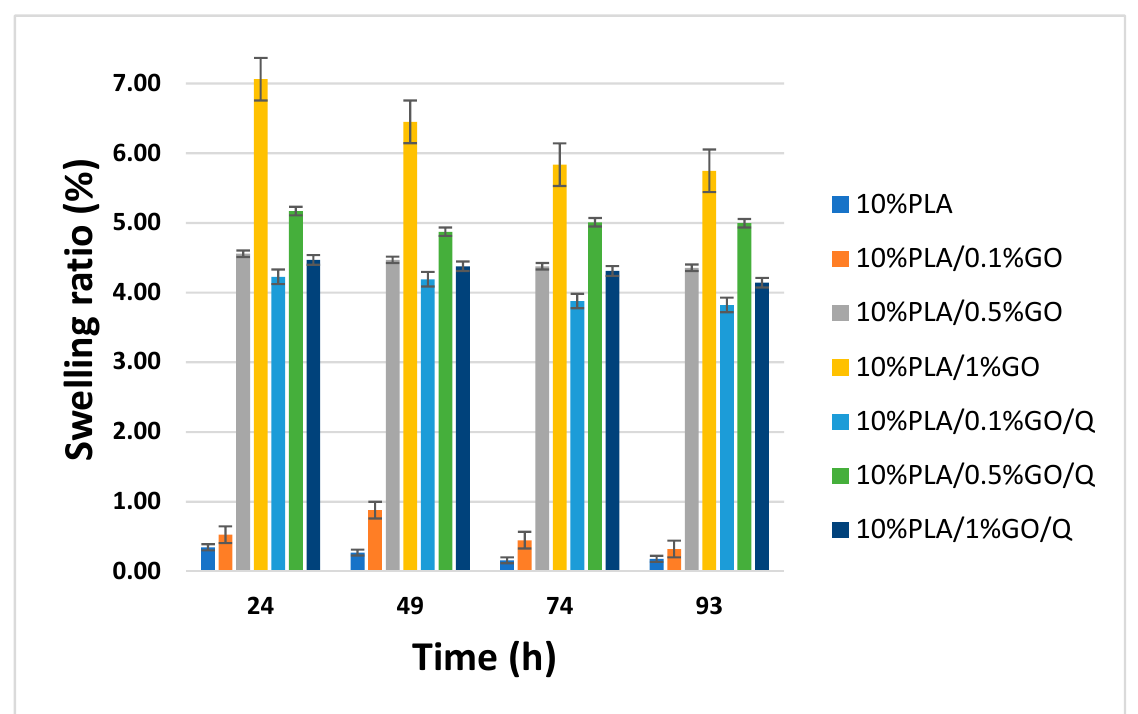
Figure 5. Swelling kinetics of the scaffolds.